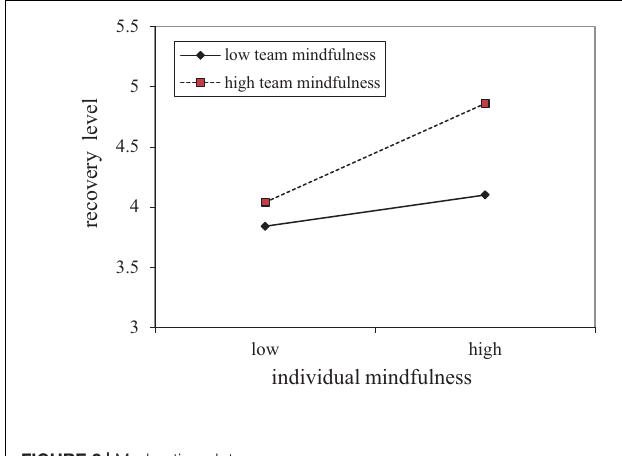
FIGURE 2 | Moderation